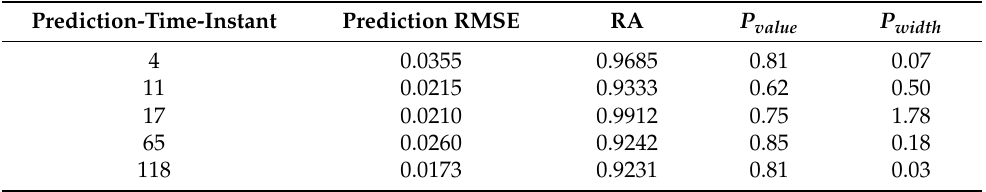
Table 12. The RMSE, RA, P value and P width of 5 time-instant of interest on tests 3 (B0007 and exponen- tial equation).